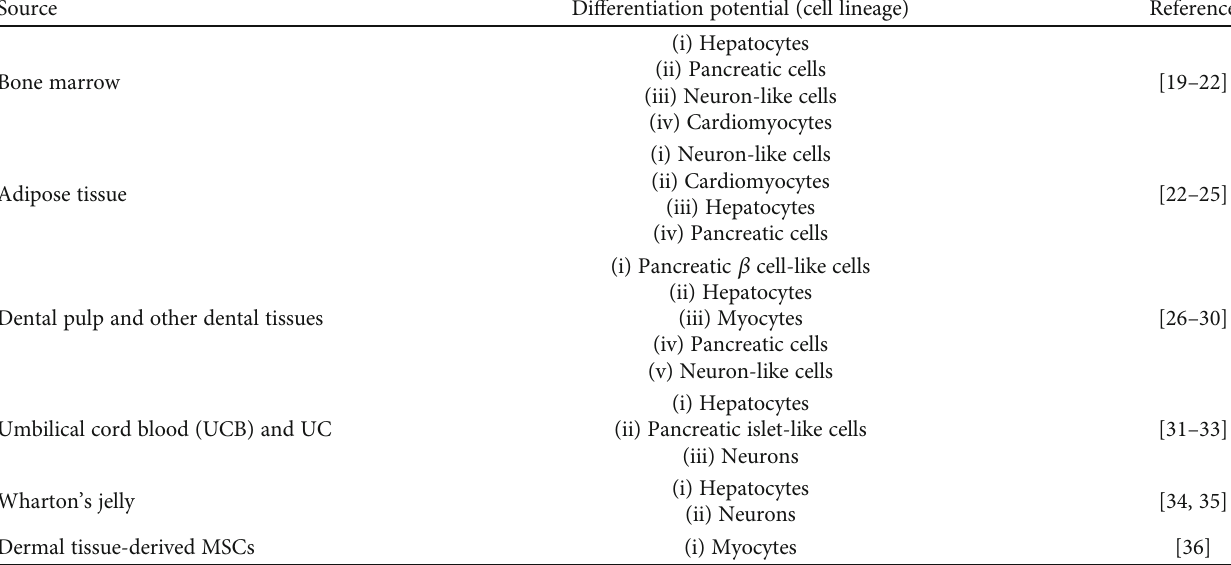
Table 1: Sources of mesenchymal stem cells and their di ff erentiation potential.